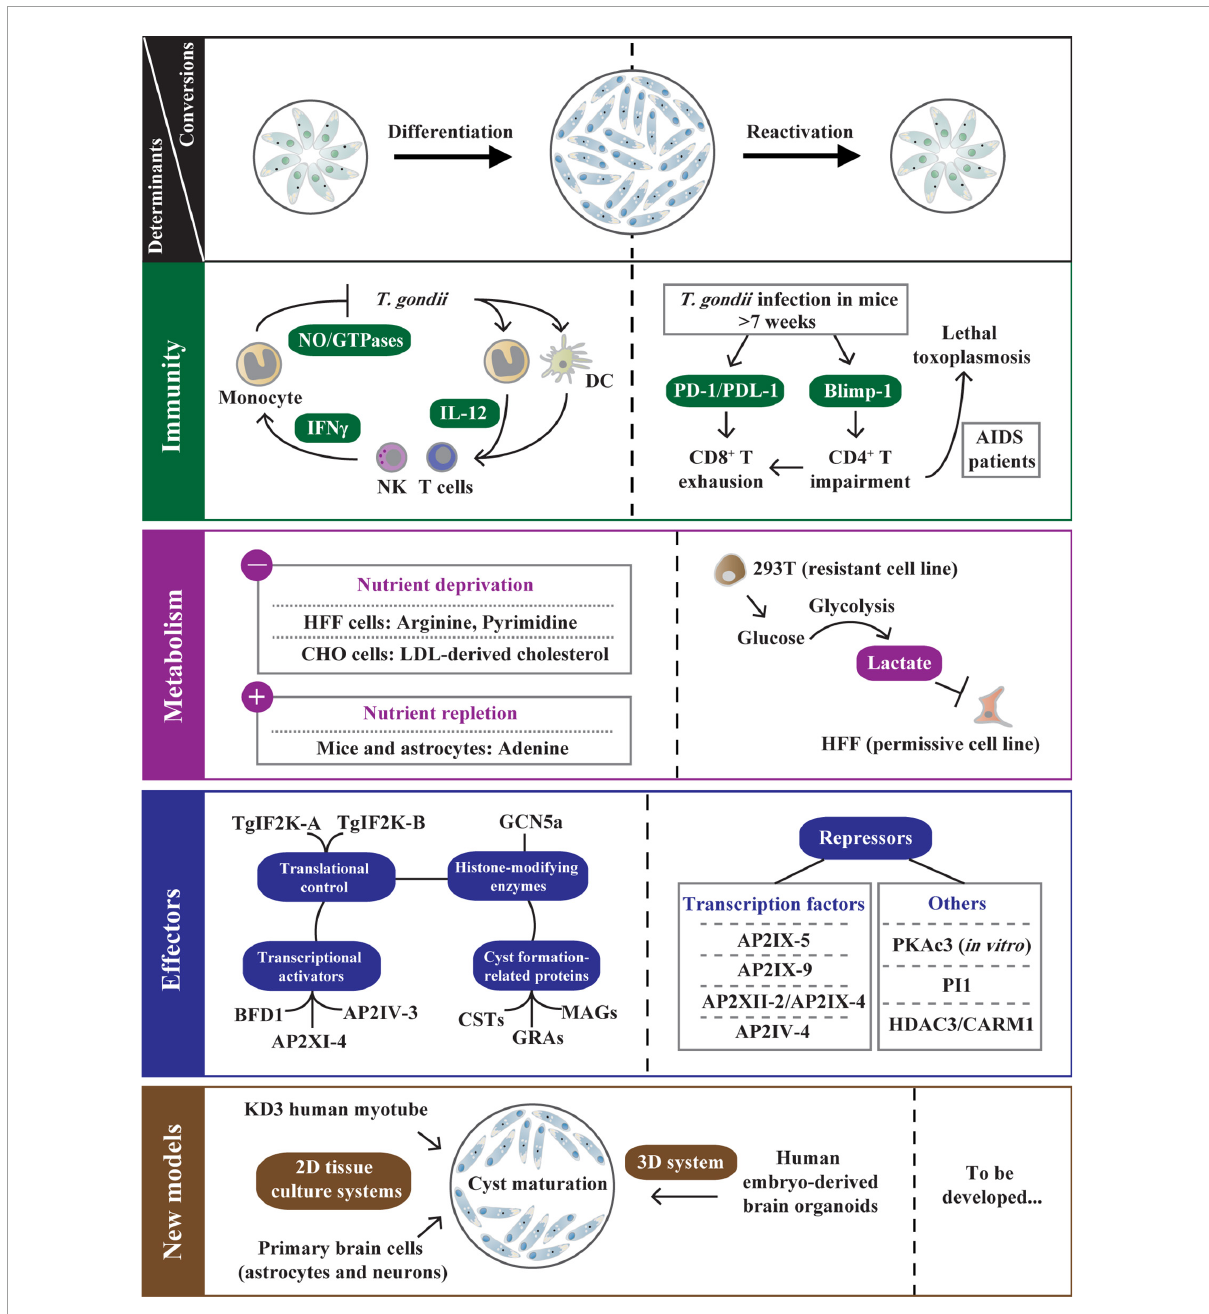
FIGURE2 The determinants regulating bradyzoite development and reactivation. After T. gondii infection, host microenvironment adjustments (immune response and metabolite supply) are associated with tachyzoite-bradyzoite interconversion. The IL-12/IFN- γ pathway is an effective strategy primarily used to control T. gondii infection in immunocompetent hosts. Despite this, some tachyzoites escape immune destruction and differentiate into bradyzoites. In chronically infected mice (weeks postinfection > 7) or T. gondii -infected AIDS patients, the host CD4 + T cell impairment that is regulated by Blimp-1 enhances PD-1/PDL-1-mediated CD8 + T cell exhaustion, resulting in bradyzoite reactivation. The host metabolites also directly impact T. gondii differentiation under nutrient-deprived conditions (deprivation of arginine, pyrimidine, etc.) or nutrient-replete conditions (exogenous addition of adenosine and lactate). In addition, T. gondii relies on various strategies to optimize its persistence, including the transcriptional activation or repression by TgAP2 factors and other effectors (PKAc3, PI1, etc.), the translational control via TgIF2K-A/TgIF2K-B-dependent eIF2 α phosphorylation, GCN5a-mediated post-translational modifications (PTMs), and the biogenesis of the cyst wall and cyst matrix. Moreover, the development of 2D tissue culture systems with human myotubes and primary brain cells promote cyst maturation, and emerging 3D system with human brain organoids can present the natural cellular structure of T. gondii life cycle stages. These new in vitro models help elucidate the mechanisms of T. gondii stage conversion. The left side of the dotted line represents the determinants regulating bradyzoite differentiation. On the other hand, the factors contributing to bradyzoite reactivation are